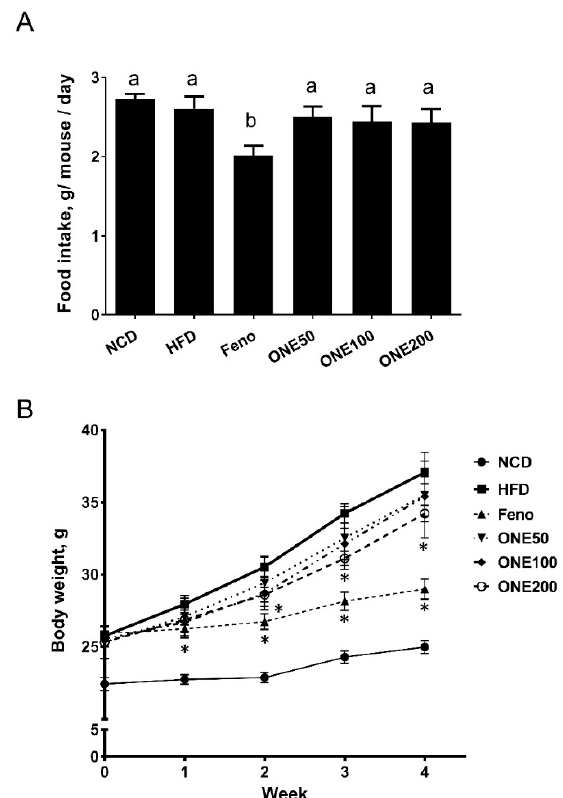
Figure 2. Food intake and body weight of mice fed with high fat diet (HFD) and ON188 (ONE). After one week of adjustment, mice were divided into six groups: Normal chow (NCD), high fat diet (HFD), fenofibrate (Feno), ONE50 (ONE at 50 mg/kg/day), ONE100 (ONE at 100 mg/kg/day), and ONE200 (ONE at 200 mg/kg/day). ( A ) Average food intake and ( B ) body weight were measured during 4-week of Feno and ONE co-feeding period. All values are presented as mean ± SEM ( n = 7), * p < 0.05 vs. HFD feeding group. Different letters indicate statistical significance among treatment groups.